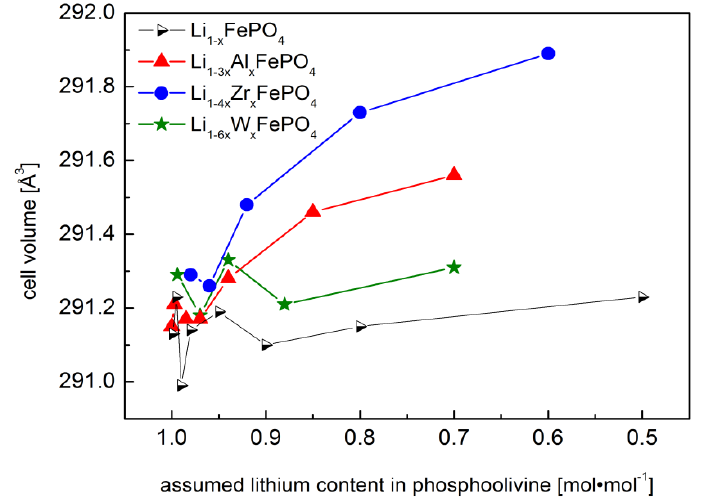
Figure 3. Effect of dopant concentration on the unit cell volume for pure and substituted phosphoolivines